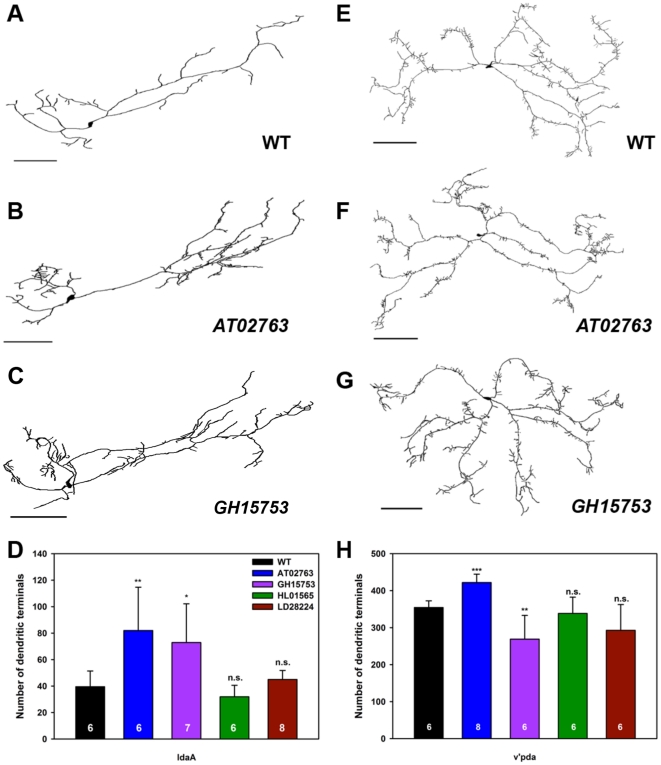
Isoform-specific Tutl overexpression differentially regulates dendrite branching in class II and III da neurons.Representative tracings of class II ldaA (A–C) and class III v'pda (E–G) neurons from third instar larvae. Anterior is left and dorsal up and size bars represents 150 microns for ldaA and 100 microns for v'pda. (A) Wild-type (WT) ldaA neuron. Overexpression of the non-membrane bound Tutl AT02763 (B) and GH15753 (C) isoforms increased terminal dendritic branching in ldaA neurons. (D) Quantitative analyses of dendritic branching revealed a statistically significant increase with AT02763 and GH15753 overexpression relative to wild-type controls. (E) Wild-type (WT) v'pda neurons. Overexpression of the Tutl AT02763 isoform (F) increased terminal dendritic branching, whereas overexpression of the Tutl GH15753 isoform (G) decreased terminal dendritic branching in v'pda neurons. (H) Quantitative analyses of dendritic branching revealed a statistically significant increase with AT02763 and decrease with GH15753 overexpression relative to controls. The total n value for each genotype quantified is reported on the bar graph. Statistically significant p values are reported on the graph as follows (* = p<0.05; ** = p<0.01; *** = p<0.001; n.s. = not significant). Genotypes (A–H): WT: GAL4C161,UASmCD8::GFP/+; AT02763: UAS-tutlAT02763/+;+;GAL4C161,UASmCD8::GFP/+; GH15753: UAS-tutlGH15753/+;+; GAL4C161,UASmCD8::GFP/+; HL01565: UAS-tutlHL01565/GAL4C161,UASmCD8::GFP; LD28224: UAS-tutlLD28224/GAL4C161,UASmCD8::GFP.